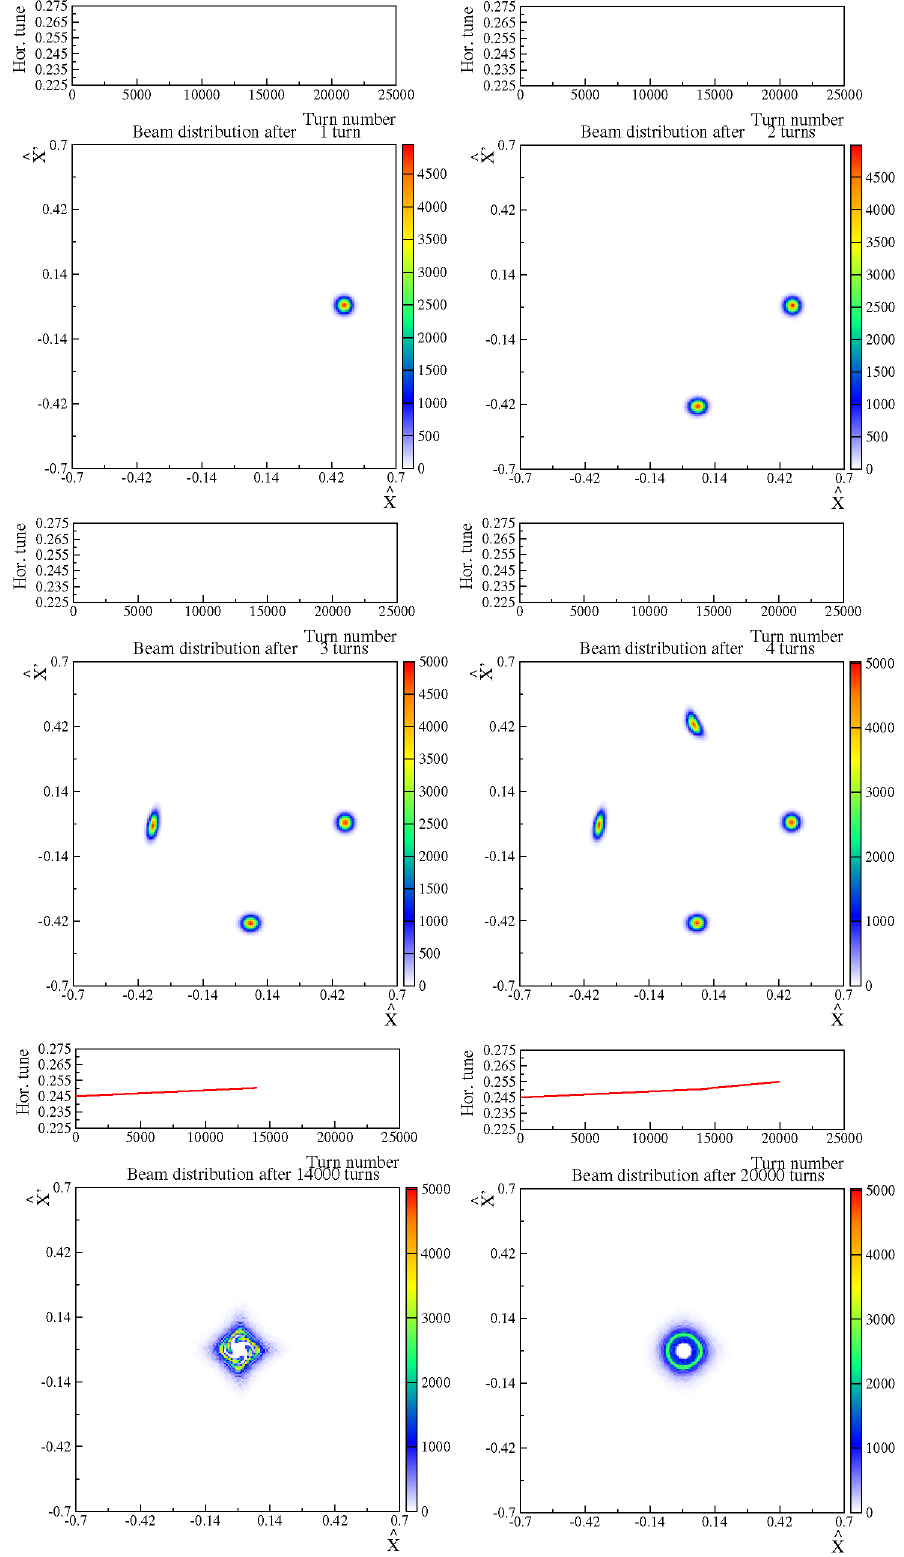
FIG. 1. (Color) Multiturn injection by means of trapping in stable islands of transverse phase space. Four turns are injected and the beamlets merged by crossing the fourth-order resonance. The tune variation is reported in the upper part of each plot. As a result a hollow beam in the transverse phase space is